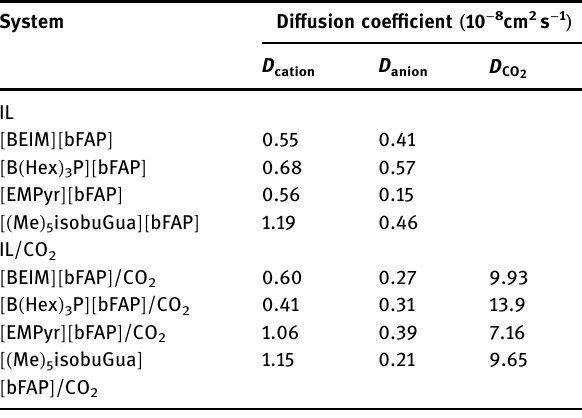
Table 4: Di ff usion coe ffi cient of cation, anion, and CO 2 at 298 K